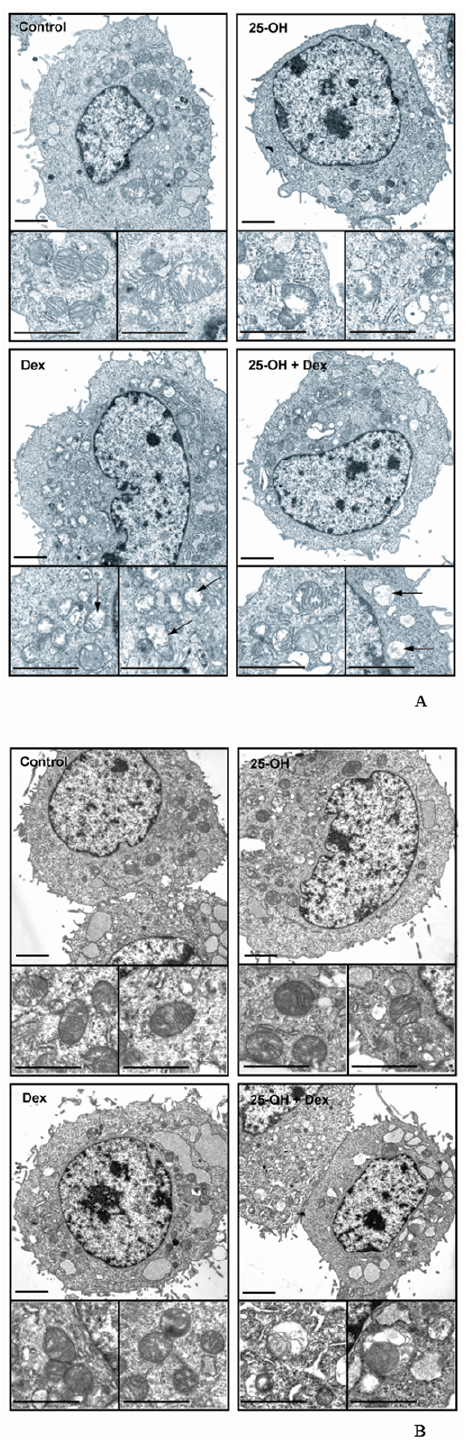
Figure 8. Alteration of oligodendrocytes cytoplasm by 25-OH and Dex. Transmission electron micrographs of 158N cells incubated or not with 25OH (10 2 5 M) and/or Dex (10 2 6 M) during 24 h (A) or 48 h (B). The cells were fixed with 2.5% glutaraldehyde in 0.1 M cacodylate buffer (pH 7.2) for 1 h at 4 u C and TEM was performed. Insets: magnification showing representative mitochondria. By comparison with controls, mitochondria cristae seem to disappear. They partly lost their normal structure (arrows). Scale bar=2 m